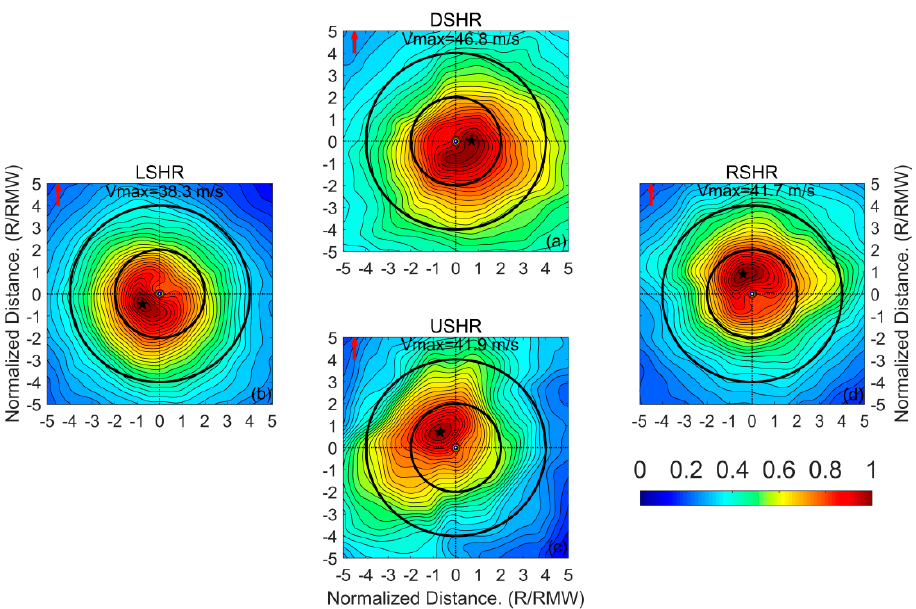
Figure 12. Composites of normalized two-dimensional SMAP wind speed fields for: ( a ) Wind shear direction and storm motion direction are equal (DSHR); ( b ) wind shear is on the left side of the storm motion (LSHR); ( c ) wind shear and storm motion are in the opposite direction (USHR); and ( d ) wind shear is on the right side of the storm motion (RSHR). Other details are the same as in Figure 5.